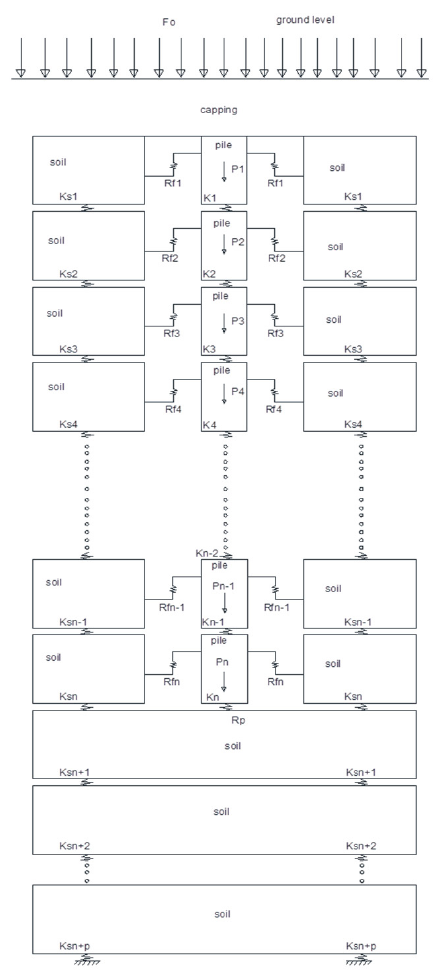
Figure 5. Soil–pile analytical model.